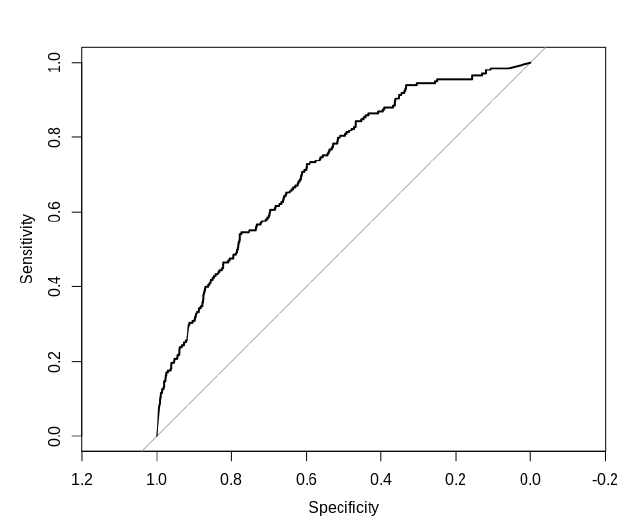
Figure 7. ROC Curve from blind test in the CNN over 500